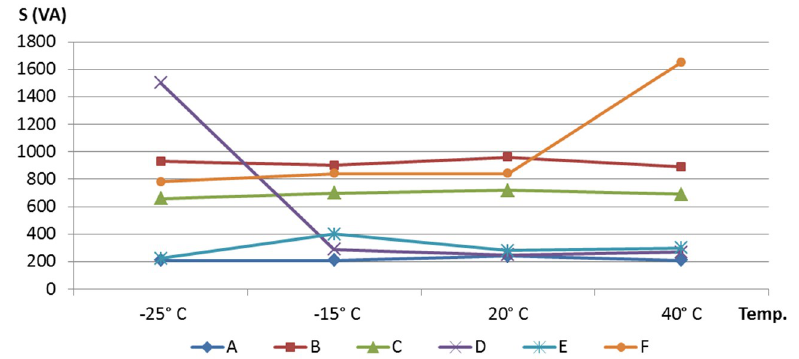
Figure 4. Total standby apparent power consumption variation, with temperature.